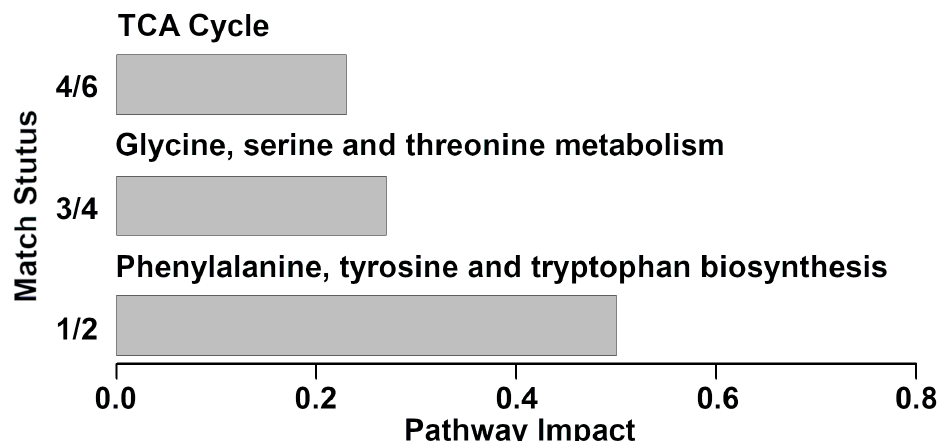
Figure 3. Metabolic pathways evidenced by enrichment analysis performed on the milk’s metabolites significantly differently between the two groups (impact value > 0.2).